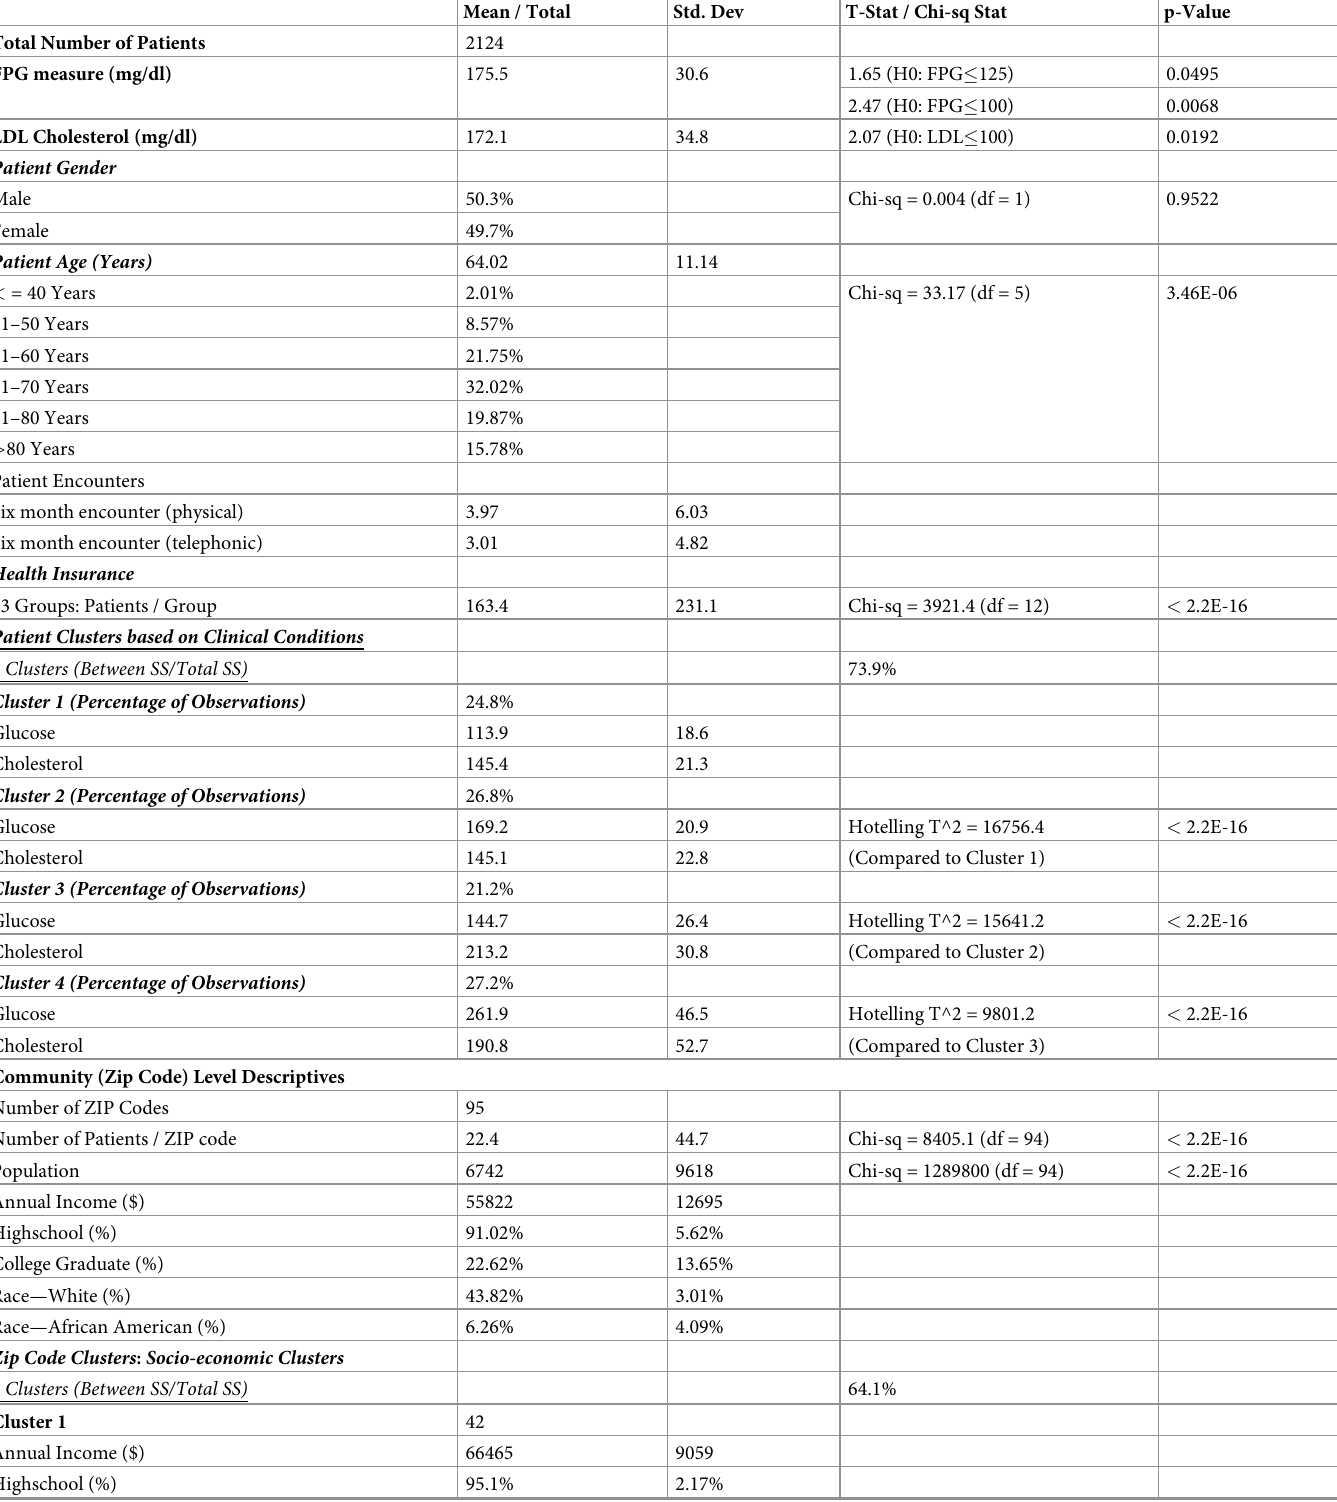
Table 1. Data description and cluster